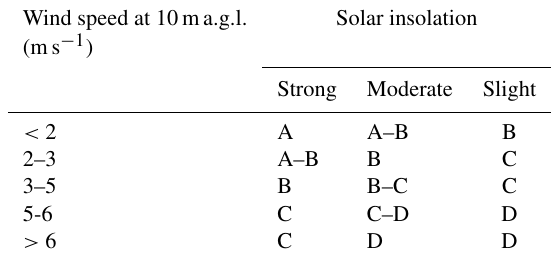
Table 2. Atmospheric stability classification scheme (Pasquill, 1961; Turner, 1970) based on surface wind speed and solar inso- lation: A – very unstable; B – moderately unstable; C – slightly unstable; D – neutral. The additional stability classes E for slightly stable and F for stable occur only at night. For A–B take the average of stability parameters (Table 3) for A and B. Wind speed at